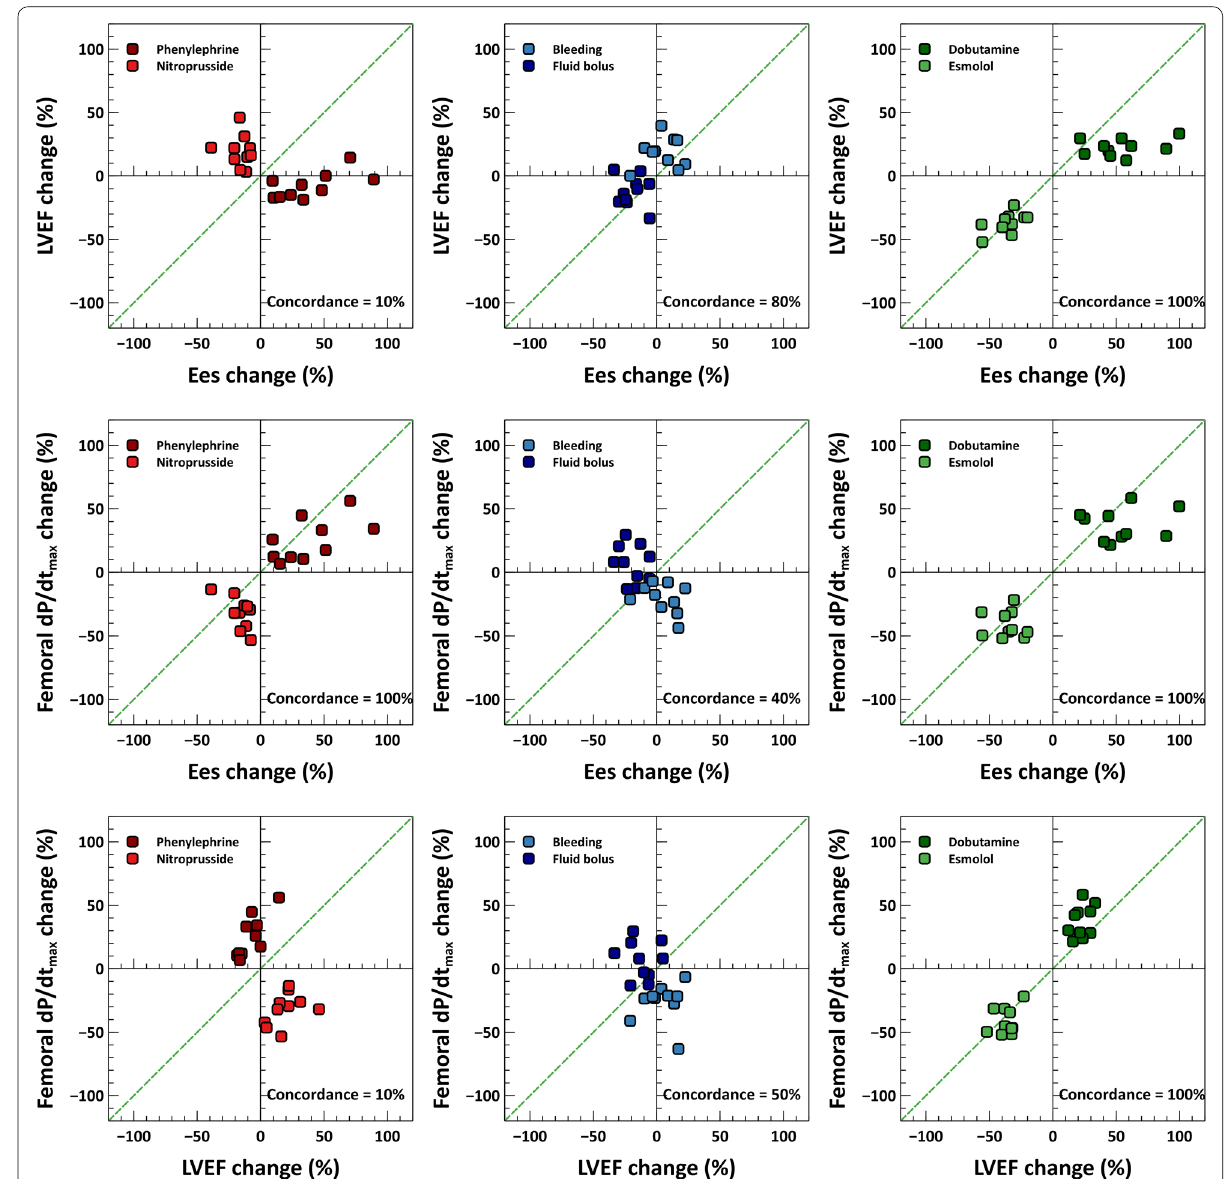
Fig. 1 Concordance analysis. Four-quadrant plots showing the relationship between the percentage changes in left ventricular ejection fraction (LVEF) and left ventricular end-systolic elastance (Ees) (upper plot), femoral d P /d t max and Ees (middle plot), and femoral d P /d t max and LVEF (lower plot). Excellent trending capability is considered when 90% of the points lie in the right-upper and left-lower ≥